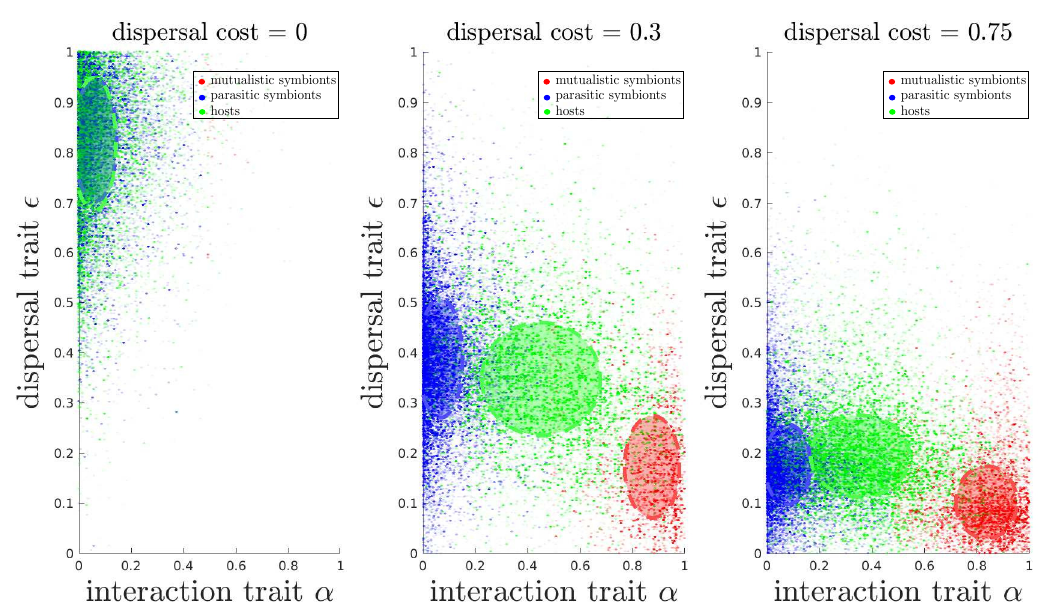
Figure SI.11. Joint distribution of the host (green), the parasitic symbiont (blue) and the mutualistic symbiont (red) populations in the traits domain for mortality m = 0 . 03 and an increasing dispersal cost d ∈ { 0 , 0 . 3 , 0 . 75 } . The ellipses correspond to the standard deviation. The 48 runs averaged in Figure 6 are plotted together. Other parameters are c m = 0 . 3 , w h = 1 , γ C = 0 . 2 , f β max = 0 . 5